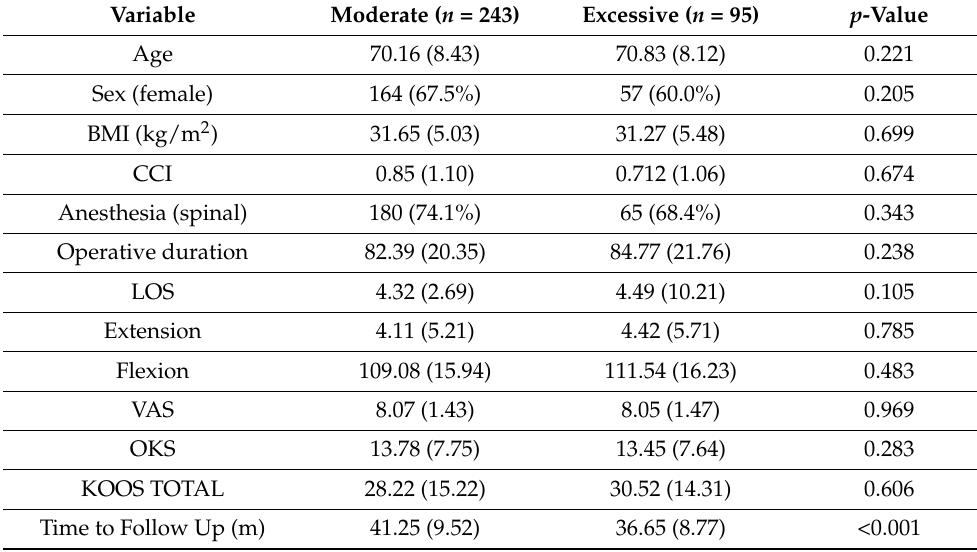
Table 1. Baseline characteristics, operative factors, and patient-reported outcomes in the moderate versus excessive